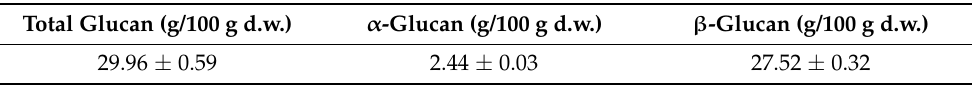
Table 2. Total glucan, α -glucan, and β -glucan content in S. crispa fruiting bodies expressed in g per 100 g of dry weight.